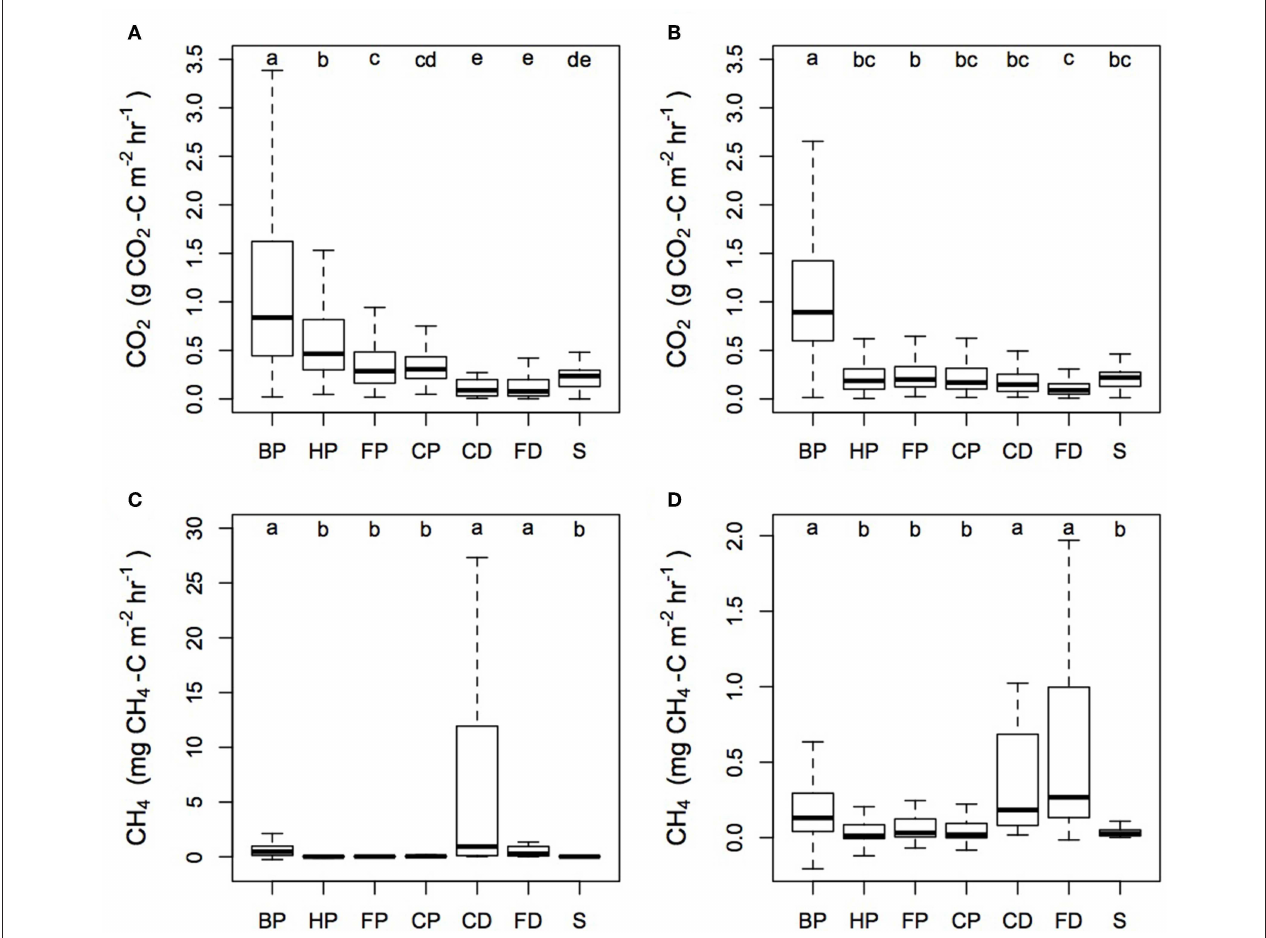
FIGURE 3 | CO 2 and CH 4 fluxes from the different microforms in Sabaju and Sebungan. Microform acronyms are in the top left of each panel and are: BP - by palm; HP - harvest path; FP - frond pile; CP - cover plants; CD - collection drain; FD - field drain; and S - stem. (A) the median and interquartile range for CO 2 fluxes from Sabaju and (B) Sebungan, and (C) the median and interquartile range for CH 4 fluxes from Sabaju and (D) Sebungan. Outliers were excluded from the graph for visual clarity.